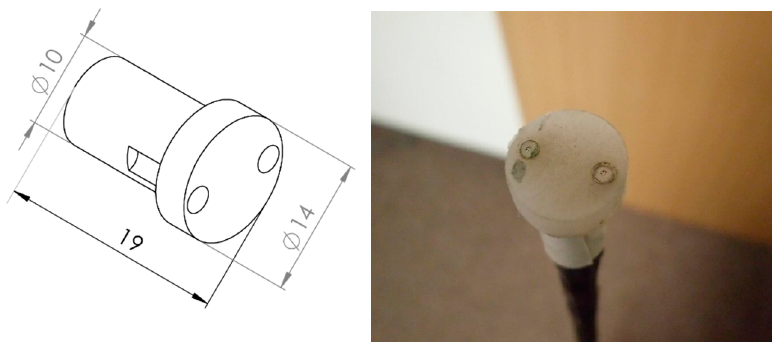
Figure 1. Construction of the 2D sound intensity probe based on two microphones (dimensional units are millimeters); ( a ) photo of real probe; ( b ) construction details.